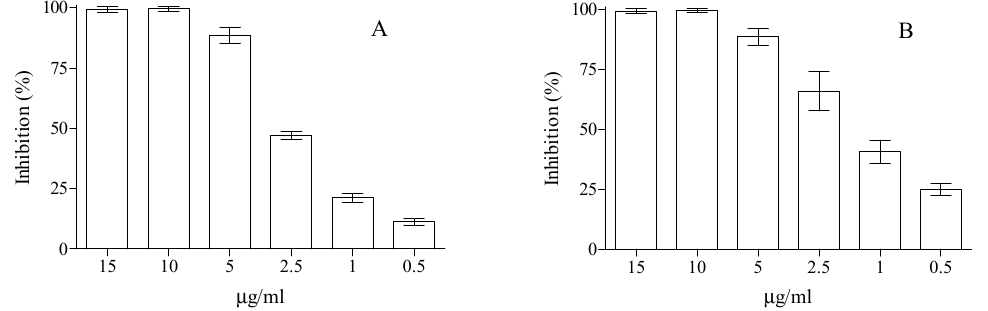
Figure 2. Radical scavenging activity of EAC measured by ( A ) DPPH and ( B ) TEAC assays. Data represent mean ± SD ( n = 3) and were expressed as inhibition %.